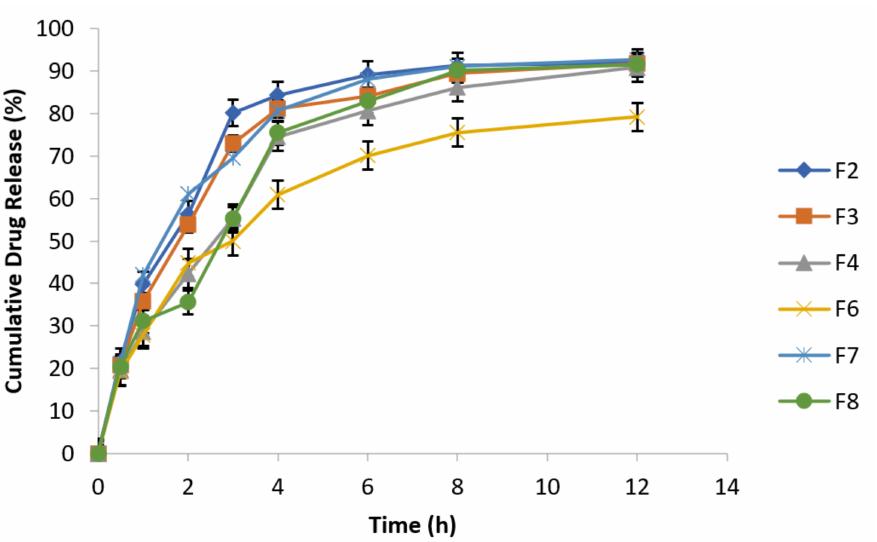
Figure 8. Effect of osmotic pressure (0.5% NaCl) on drug release at 100 rpm in 0.1 N HCl (n =